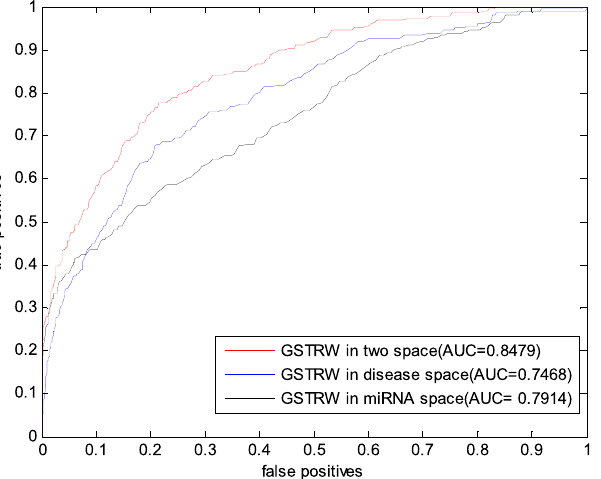
Figure 2. ROC curves and AUC values of GSTRW based on LOOCV in different